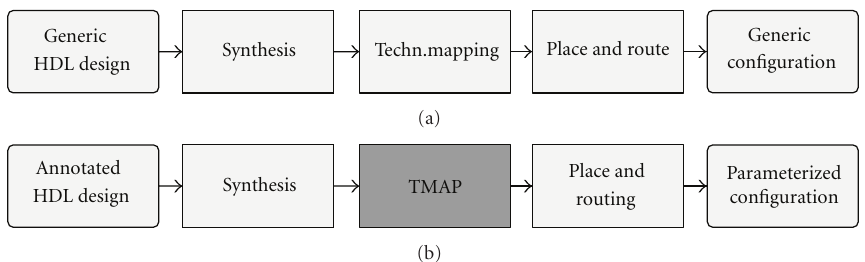
Figure 1: Conventional and TMAP FPGA tool